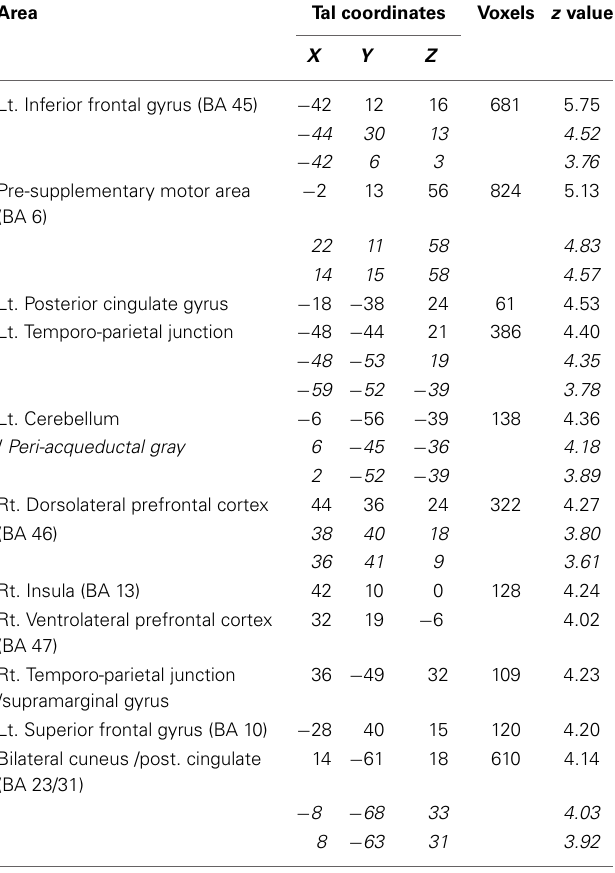
Table 1 | Areas activated in the contrast intrapersonal emotion regulation (reappraisal and suppression combined) >